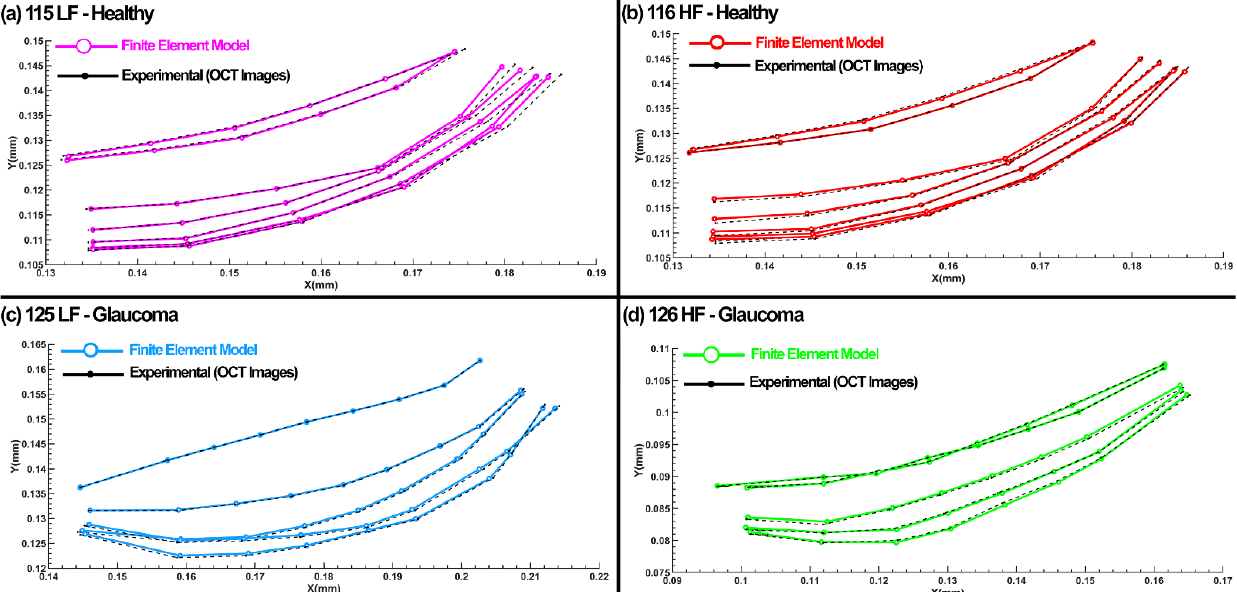
Figure 12. Nodal coordinates of the SC inner wall with SC pressure elevation in both the FE model and experimental HR-OCT imaging data in ( a ) 115LF — Healthy, ( b ) 116HF — Healthy, ( c ) 125LF — glaucoma, and ( d ) 126HF — glaucoma eyes.